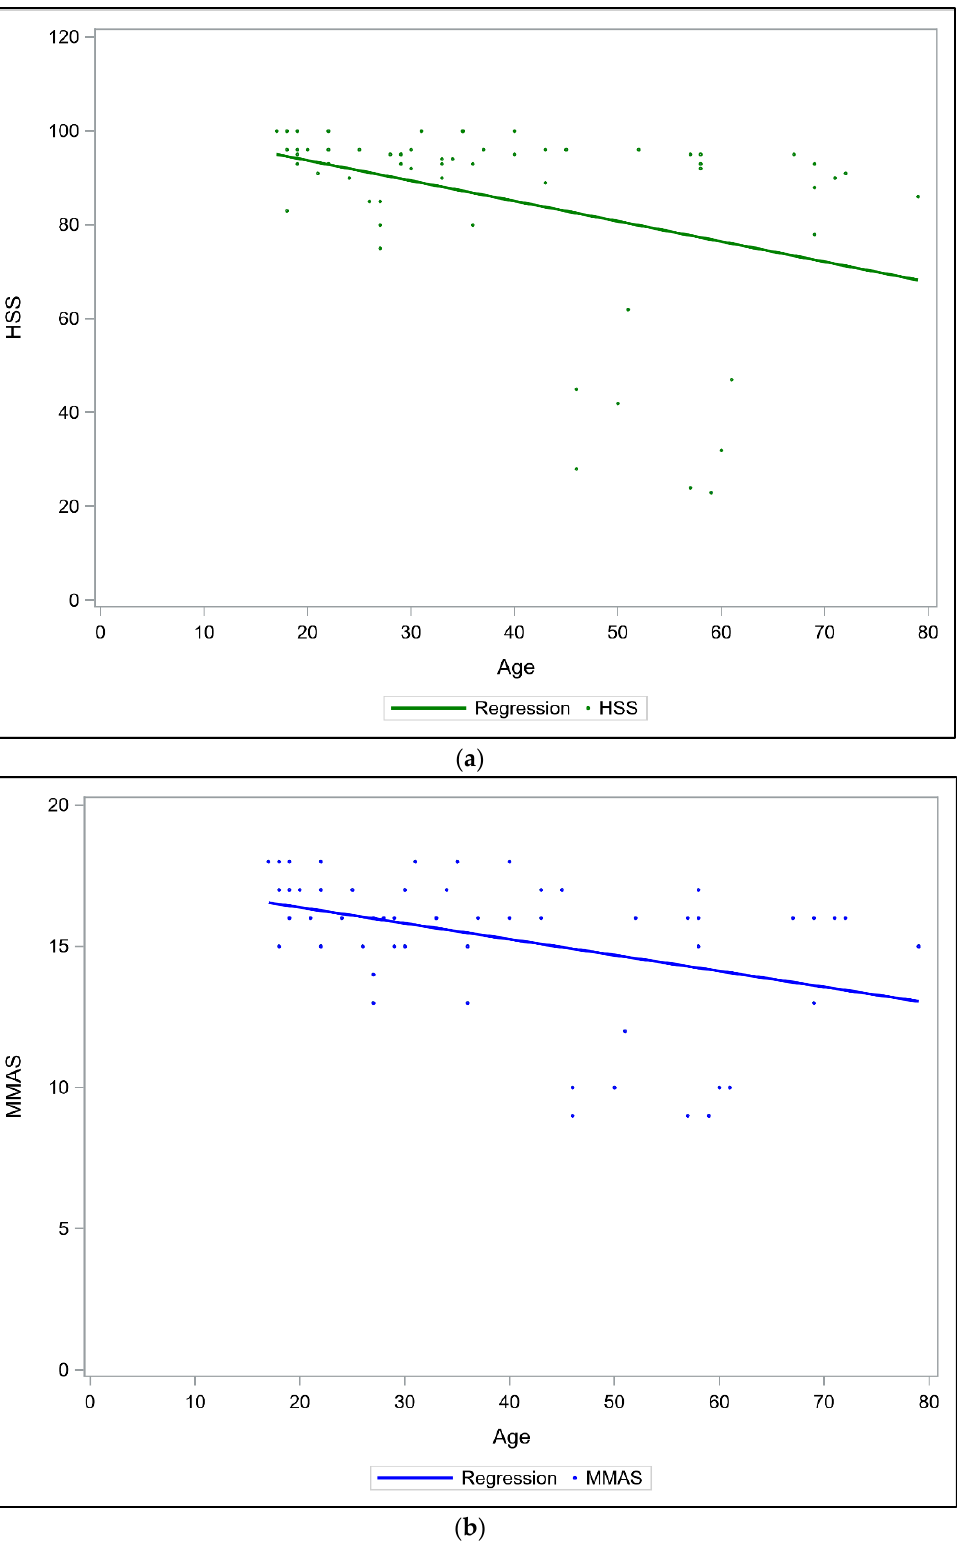
Figure 2. The correlations between patient age and postoperative functional scores. The Spearman rank correlations are − 0.41 in ( a ) HHS ( p < 0.0012) and − 0.39 in ( b ) MMAS ( p = 0.0019), indicating a negative moderate correlation between patient age and functional scores.